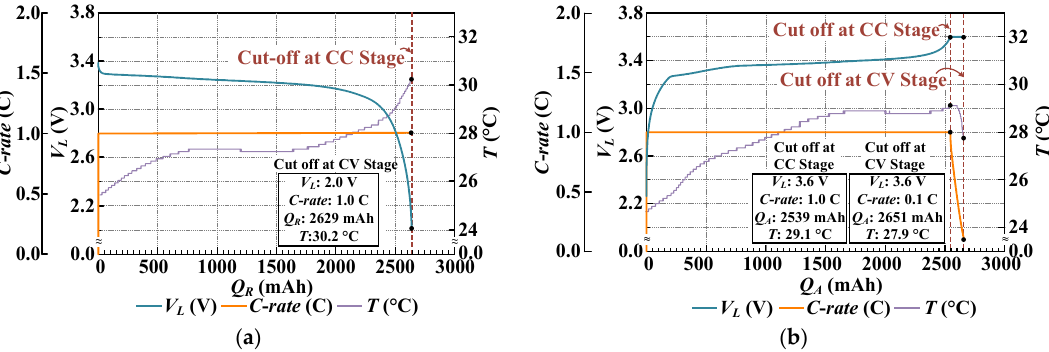
Figure 8. Waveforms of the loaded voltage, current, and temperature during standard charging and discharging of LiFePO 4 batteries: ( a ) discharging; ( b ) charging.